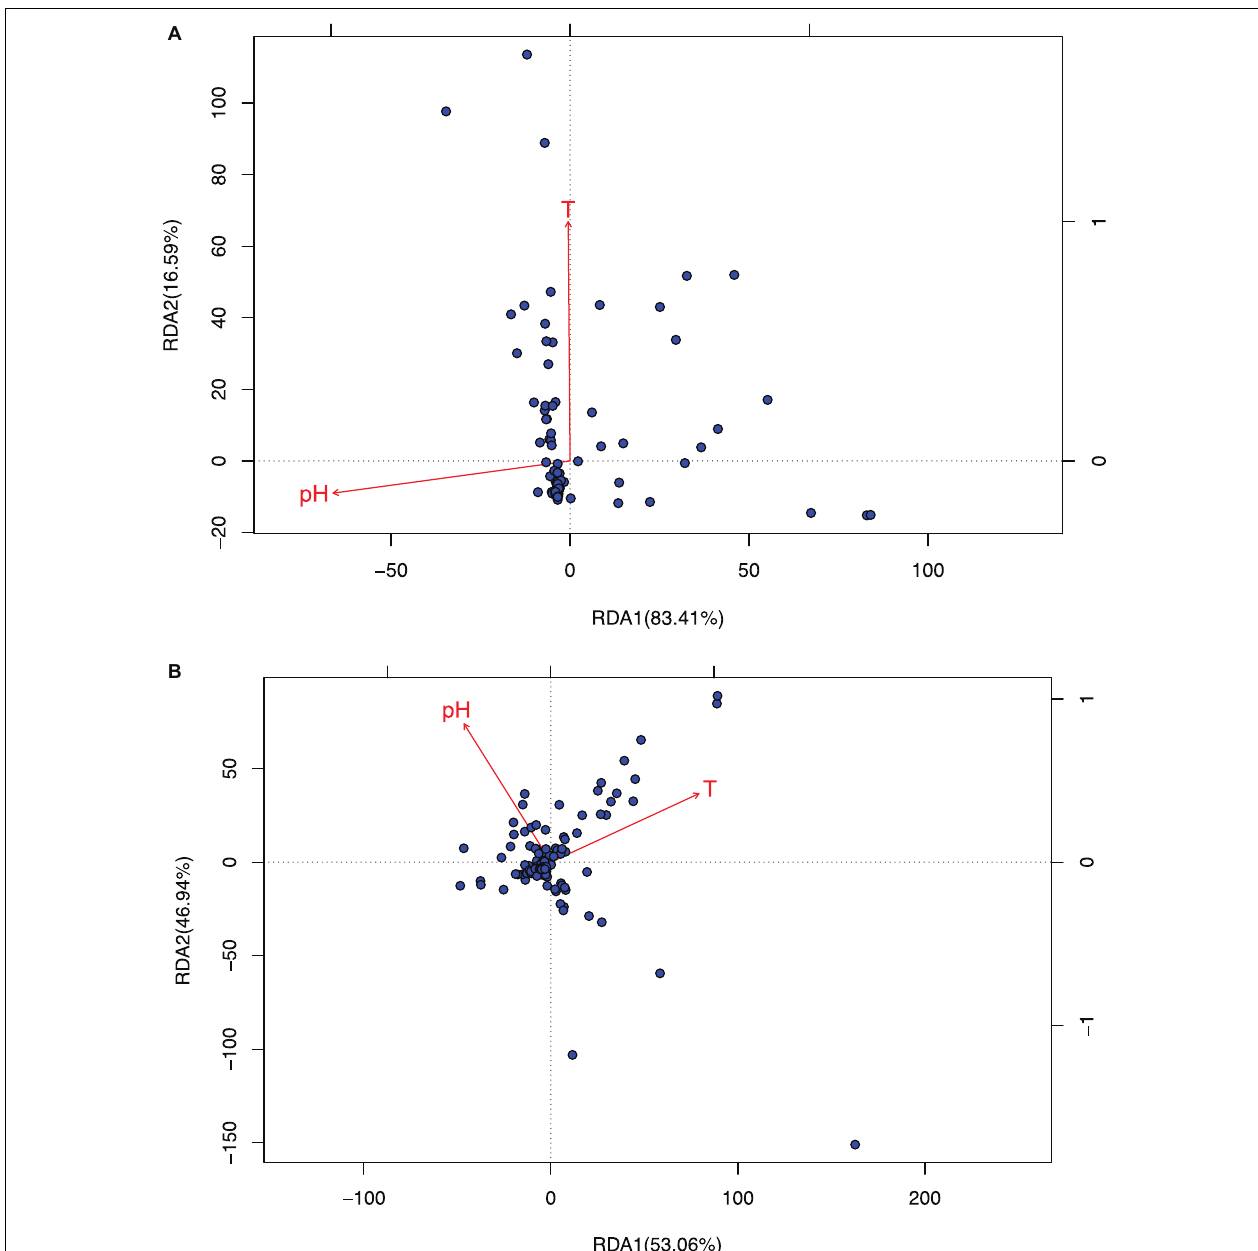
FIGURE 3 | The RDA ordination biplot for the Archaea communities. (A) For archaea and (B) for bacteria: ( i ) Legends: black dots in the graph represent for the hot-spring microbiome samples, full-line arrows for the biplot scores of the environmental variables. ( ii ) Most sample points were clustered around the origin, and some scattered far from the origin, which may be significantly different from the samples clustered around the origin. ( iii ) The angular between pH and temperature is slightly larger than π /2, which suggests that they may be negatively correlated weakly. (i v ) RDA1 and RDA2 are the linear combination of pH and temperature. In (A) , temperature and RDA1 are nearly perpendicular to each other, which suggested that temperature does not have an explanatory power for RDA1, and RDA1 is primarily explained by pH (pH and RDA1 is negatively correlated). The effect of temperature is primarily represented in RDA2, but RDA2 only weights 16.6% and therefore, in archaea, pH is the main factor to influence the community and temperature has little effect. In (B) , pH and temperature have similar explanatory power to both RDA1 and RDA2, that is, pH and temperature have similar level of influence to bacteria.